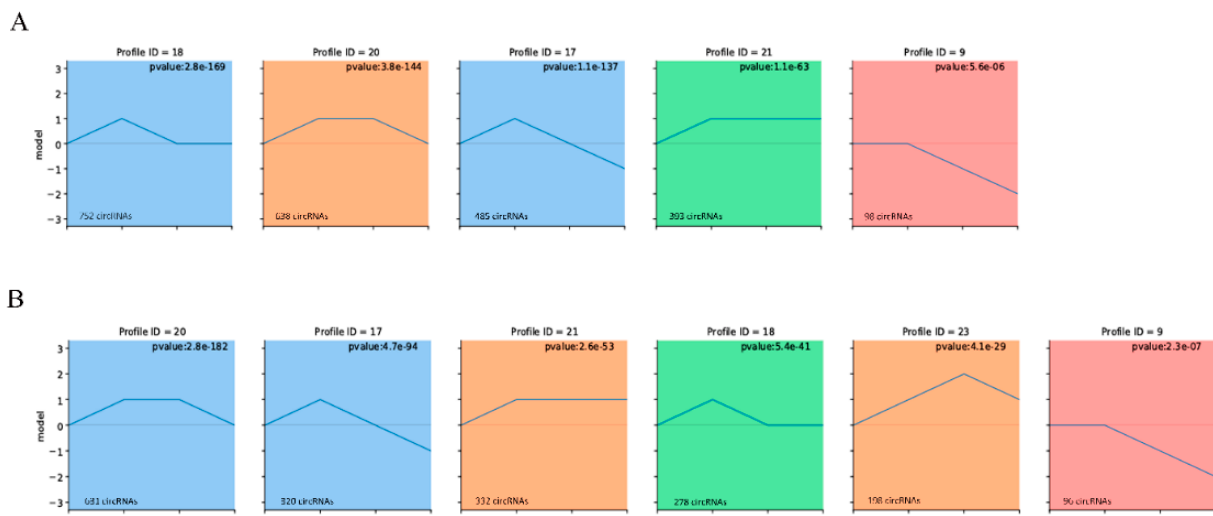
Figure 5. Time-series modules of circRNAs and construction of ceRNA network. Time-series modules of circRNAs in skeletal muscle ( A ) and subcutaneous fat ( B ). Numbers in the top indicate module number. Numbers in top right corner indicate the statistically significant p value. Numbers in lower left corners indicate numbers of circRNAs in each module. The colored profiles are indicated by different colors (Bonferroni-adjusted p values ≤ 0.05). The p value is sorted from small to large. If the profile is the same color, indicating that these profiles belong to the same cluster.